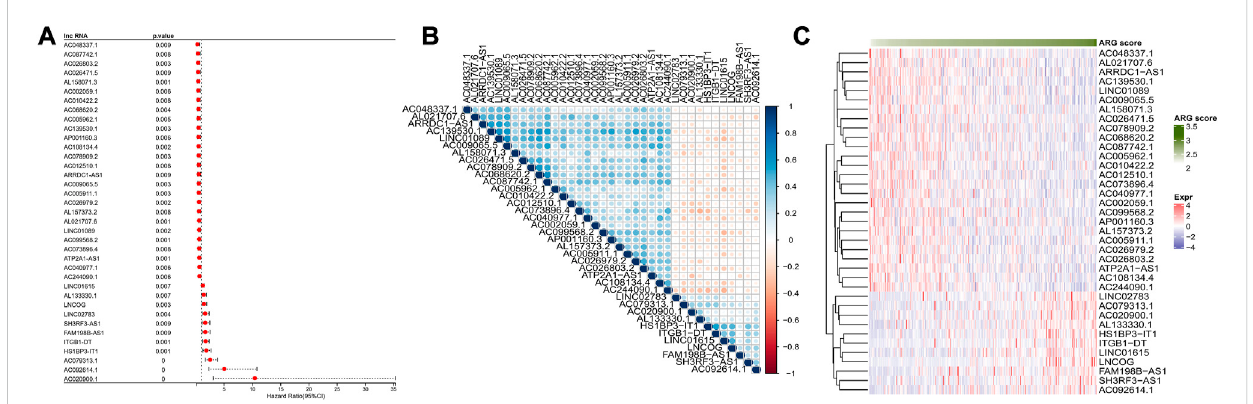
FIGURE 1 Identi fi cation of ARLs TCGA-CESC (A) Forest map of ARLs affected OS (B) Heatmap of ARLs correlation affected OS (C) 37 Expression heatmap OS related